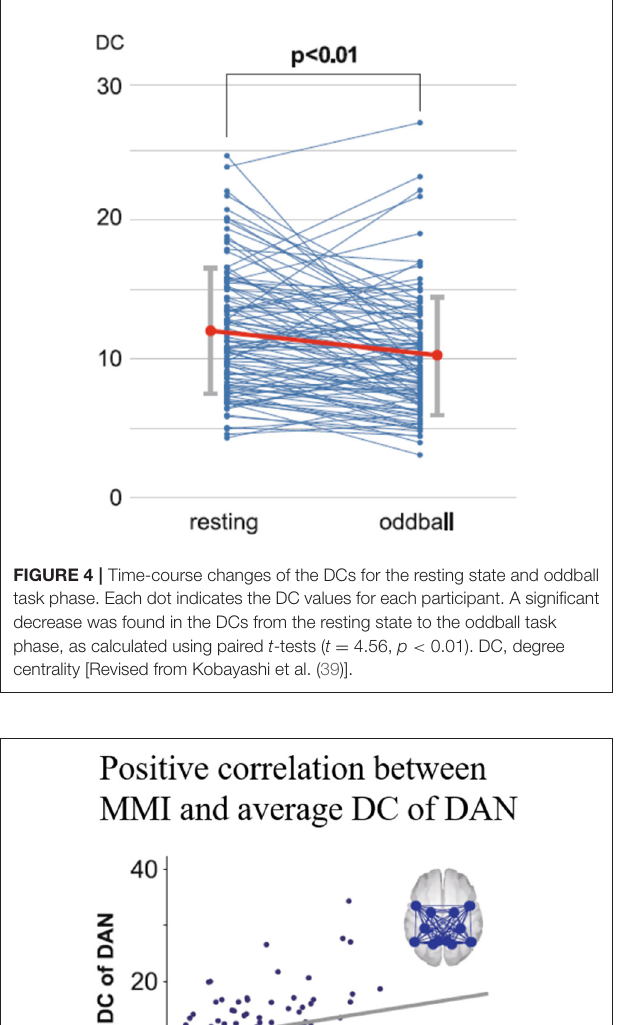
FIGURE 5 | Correlation between MMI and DCs of the DAN during the oddball task. MMI, media multitasking index scores; DC, degree centrality; DAN, dorsal attention network [Revised from Kobayashi et al.